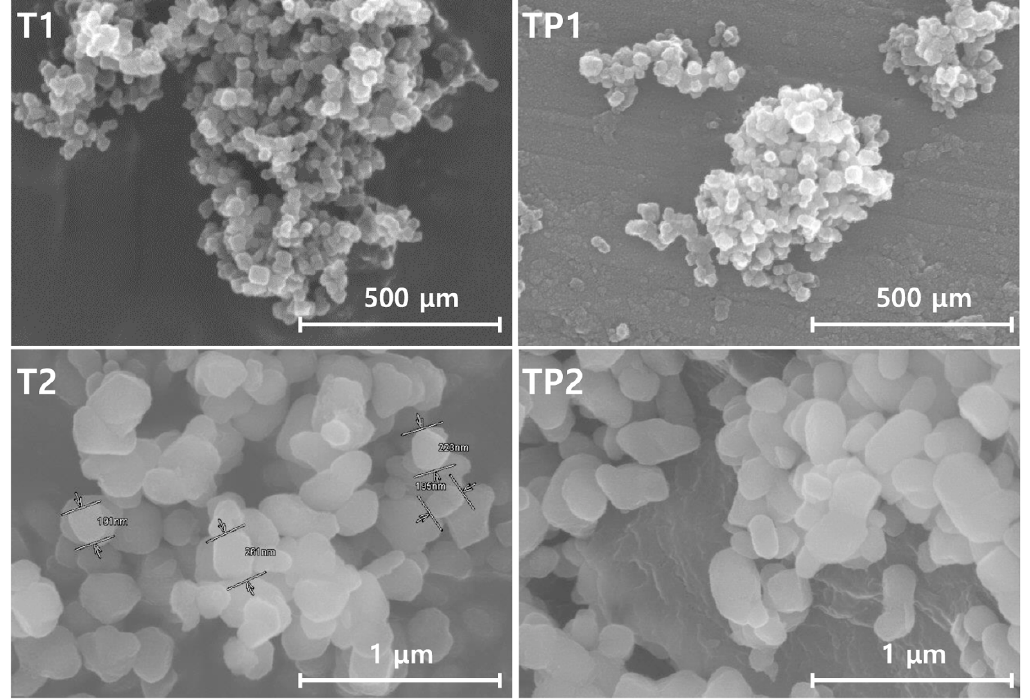
Figure 4. FE-SEM images of the pure TiO 2 nanoparticles (T1 and T2) and the TiO 2 / PMMA hybrid nanoparticles (TP1 and TP2).